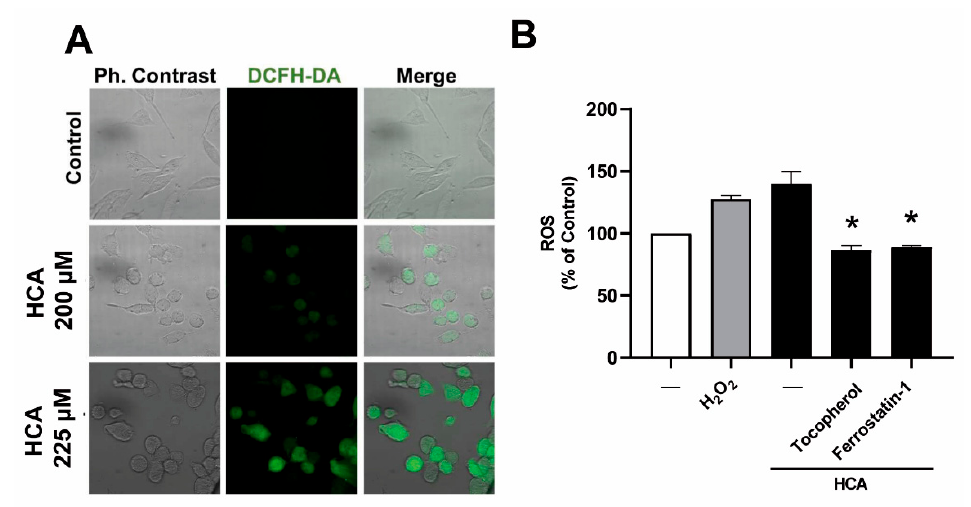
Figure 4. HCA causes an increase in ROS levels. ( A ) Representative confocal images of MIA PaCa-2 cells cultured for 48 h in the presence or absence of HCA (200 and 225 µ M). After then, the cells were incubated with 10 µM dichlorofluorescein diacetate for 30 min at 37 °C. ROS species are shown in green. ( B ) Ros levels were measured by flow cytometry. MIA PaCa-2 cells were pretreated with ROS scavengers α -tocopherol (100 µM, Vit. E) or Ferrostatin-1 (1 µM) for 1.5 h before exposure to HCA (200 µM) for 48 h. Positive control H 2 O 2 (100 µM) (the bars correspond to the mean ± SEM of three independent experiments). Student’s t -test: * p < 0.05 with respect to the controls. HCA: 2-hydroxycervonic acid. DCFH-DA: 2 ′ , 7 ′ -Dichlorofluorescin diacetate.